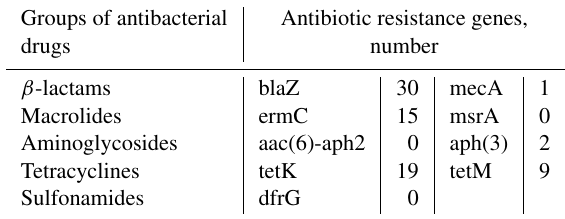
Table 5. Genes for antibiotic